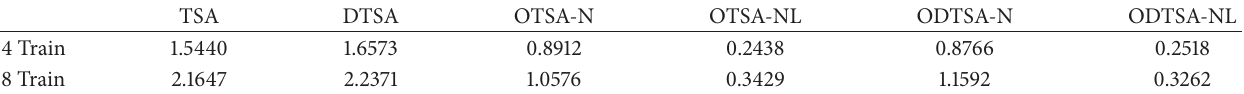
Table 3: Training time (second) on ORL